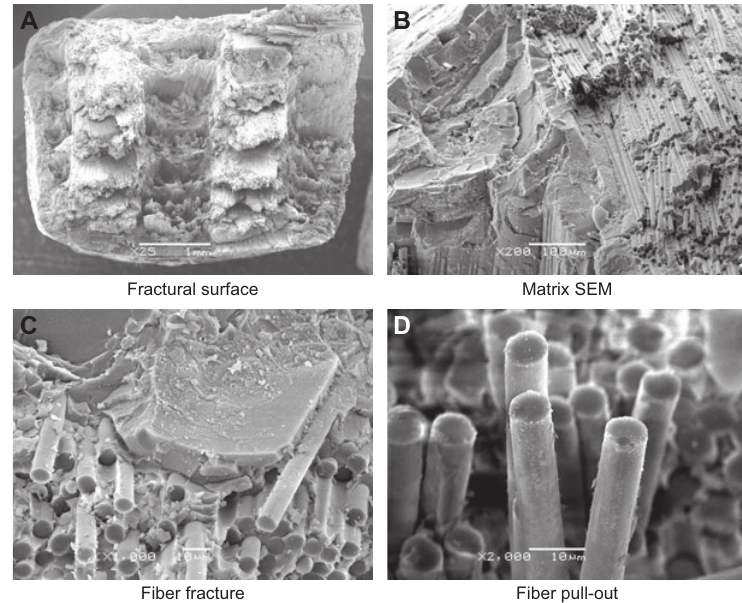
Figure 6 SEM micrographs of fracture surface of 2.5D Q